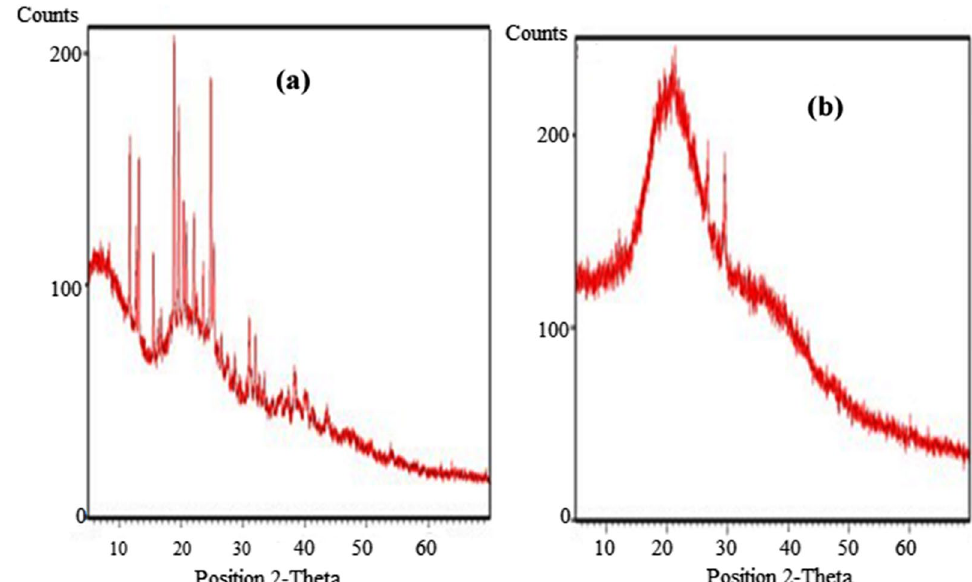
Fig. 3 a, b XRDs of a aloe vera and b